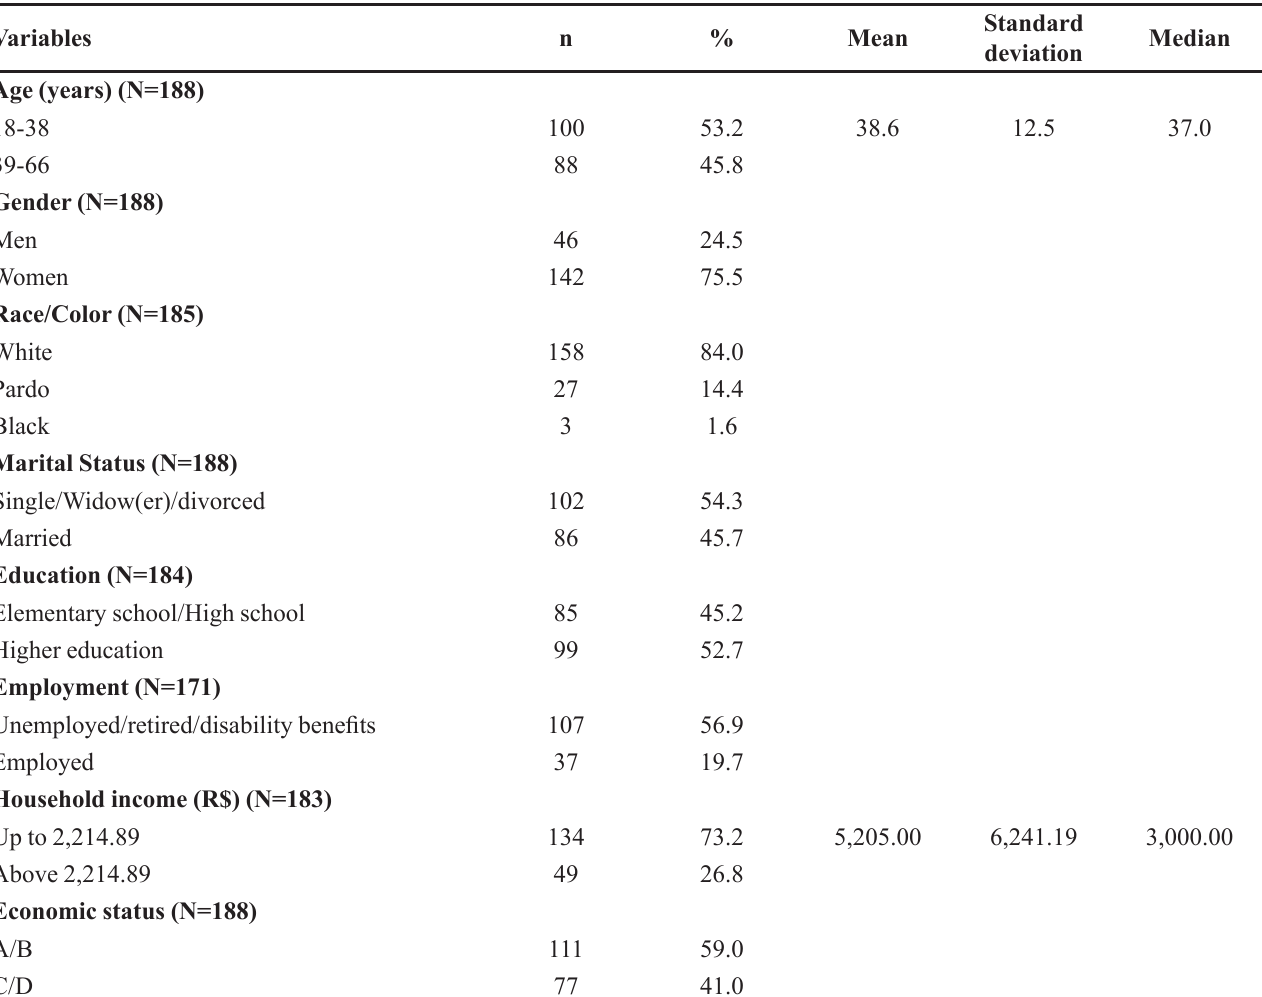
TABLE I - Demographic and socioeconomic characteristics of patients with multiple sclerosis receiving care in Reference Centers. Ceará,